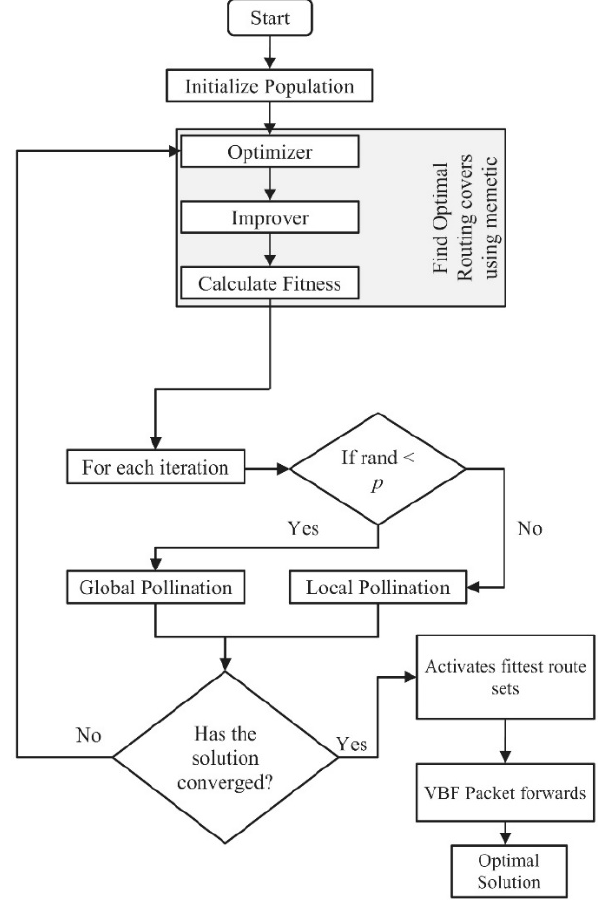
Figure 8. The proposed scheme [48].